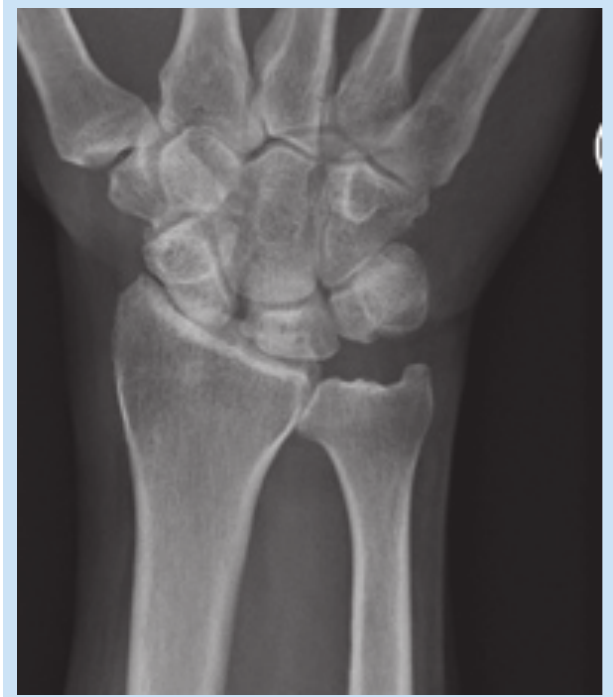
Fig. 1. Posterior anterior wrist X-ray demonstrating the widened gap between the scaphoid and the lunate bone ‘Terry Thomas’ sign. There is in addition foreshortening of the scaphoid with a ‘ring sign’. Underlying osteodegenerative changes are noted; these and the radio carpal joints are due to longstanding